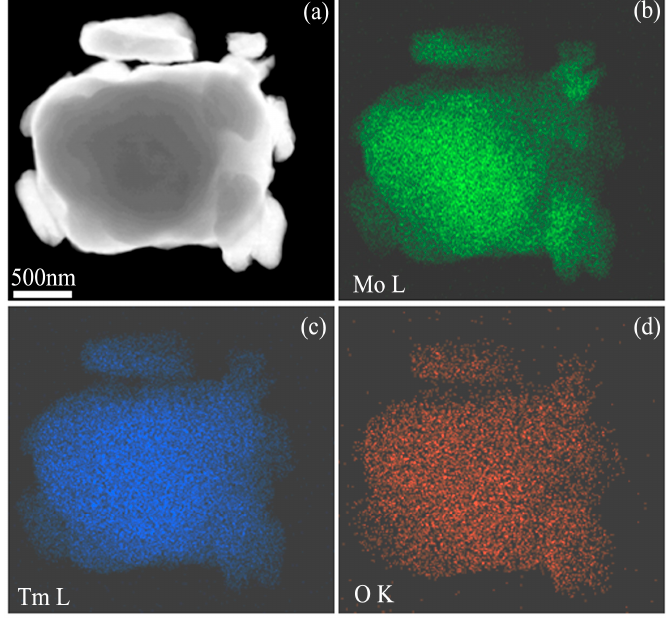
Figure 4. STEM analysis results of Mo (21 wt %) Tm 2 O 3 powder mixtures milled for 96 h; ( a ) high angle annual dark field STEM image; ( b – d ) Mo L, Tm L, and O K element mappings, respectively.